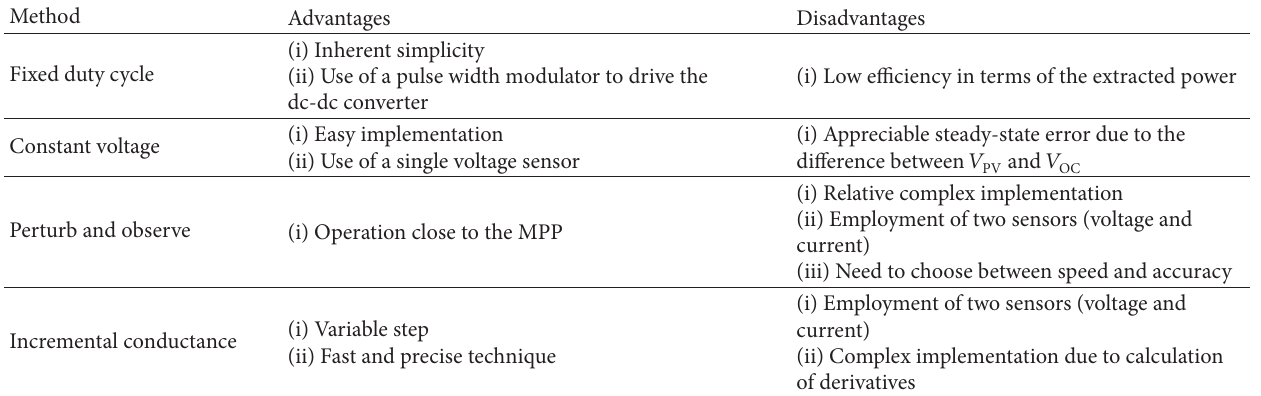
Table 1: Comparison among constant voltage, P&O, and incremental conductance MPPT control techniques.